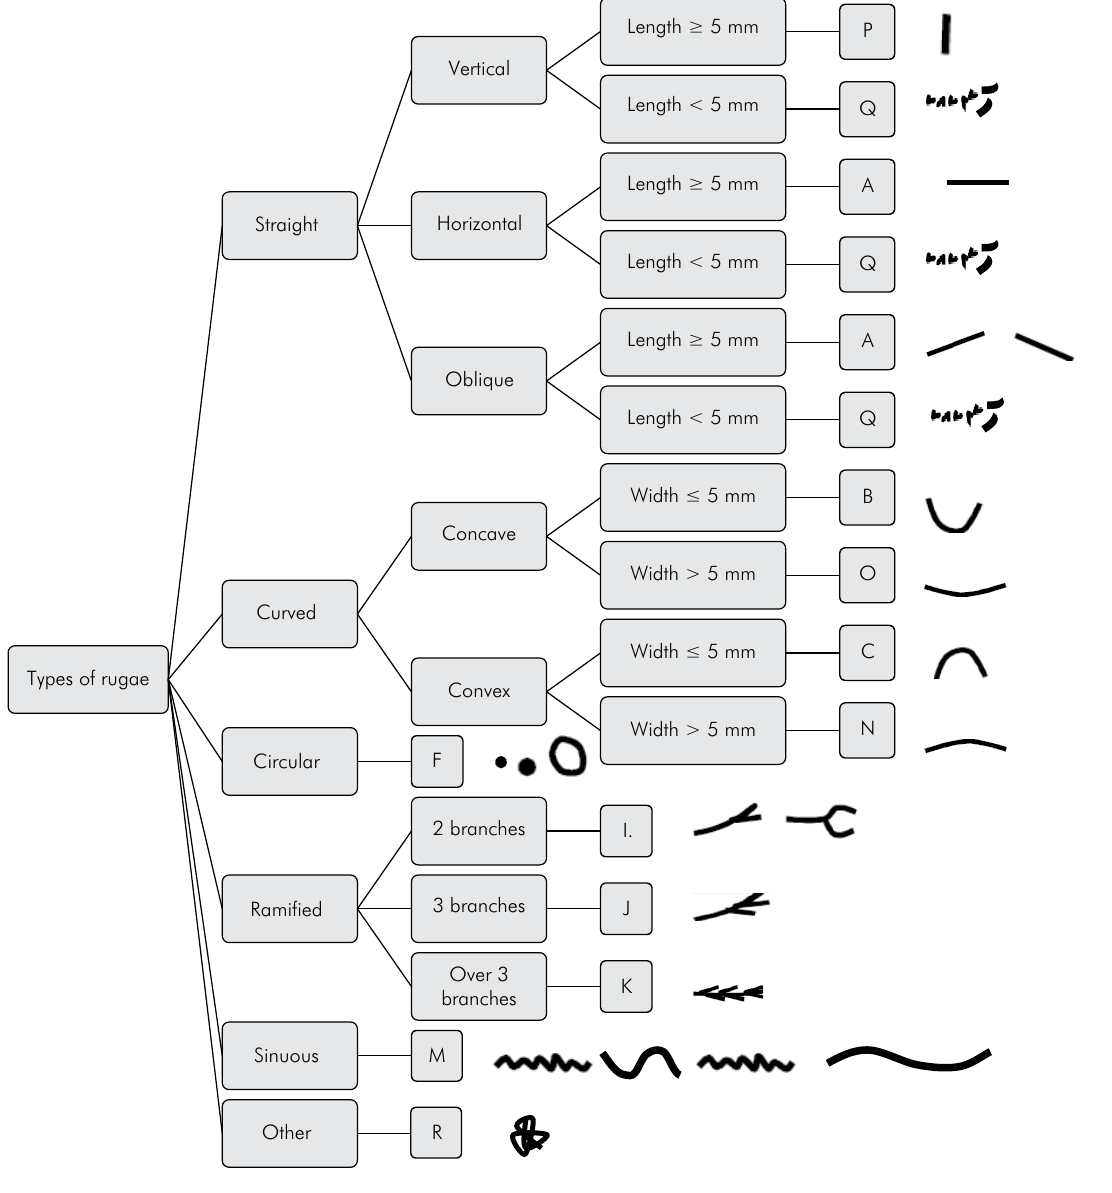
Figure 2. Proposed improvements to the 2011 Briñón